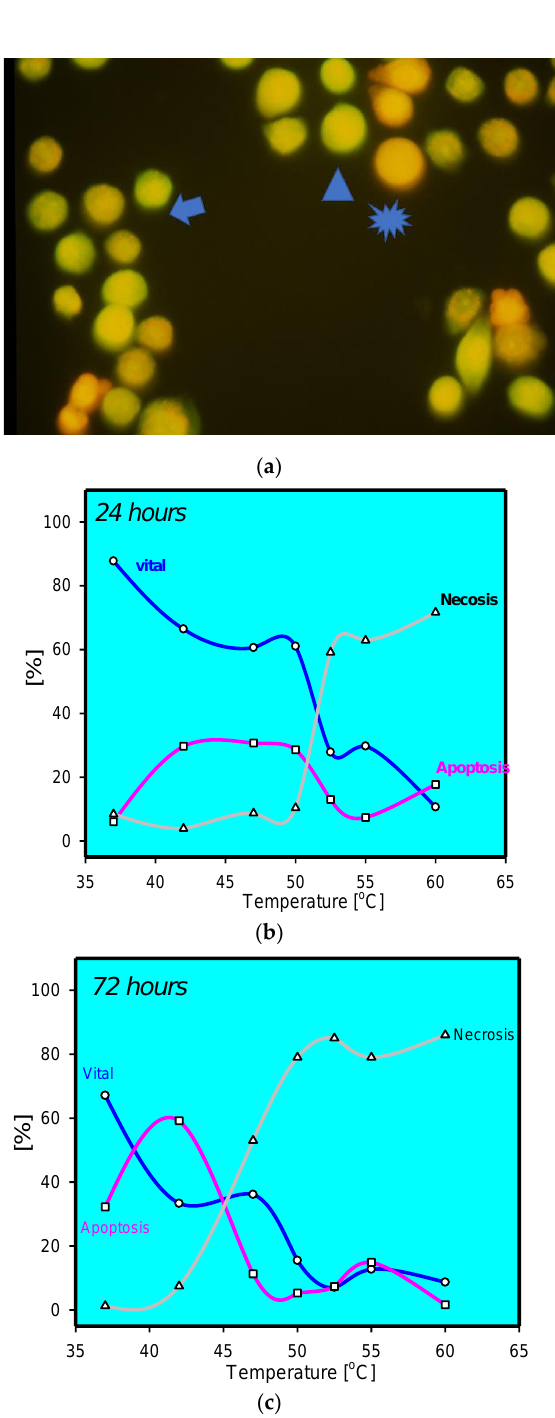
Figure 1. ( a ) Staining of thermally stress keratinocytes at 47 ◦ C after 72 h. Viable cells have intense green fluorescence (arrow head). Apoptotic cells with reduced green fluorescence and condensed red fluorescence (arrow). Homogenous red fluorescence indicative for necrotic cells (star); ( b ) percentage of live, apoptotic, and dead keratinocytes after thermal stress for 5 min at the given temperature analysed by acridine orange/ethidiumbromide, indicating a sharp increase in necrotic cells above 50 ◦ C and decrease in viability. Apoptotic keratinocytes were mainly observed at moderate tempera- tures; ( c ) percentage of live, apoptotic, and dead keratinocytes after thermal stress for 5 min at the given temperature analysed by acridine orange/ethidiumbromide after 72 h; notice the increase in apoptotic keratinocytes at moderate